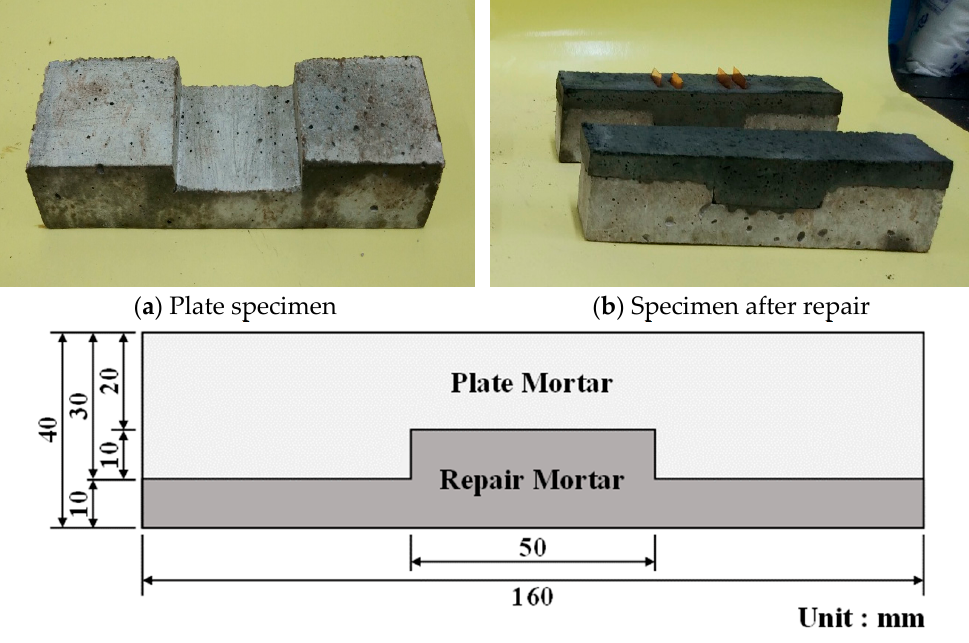
Figure 6. Flexural strength specimen after repair: ( a ) Plate specimen; ( b ) Specimen after repair; ( c ) Repair mortar evaluation